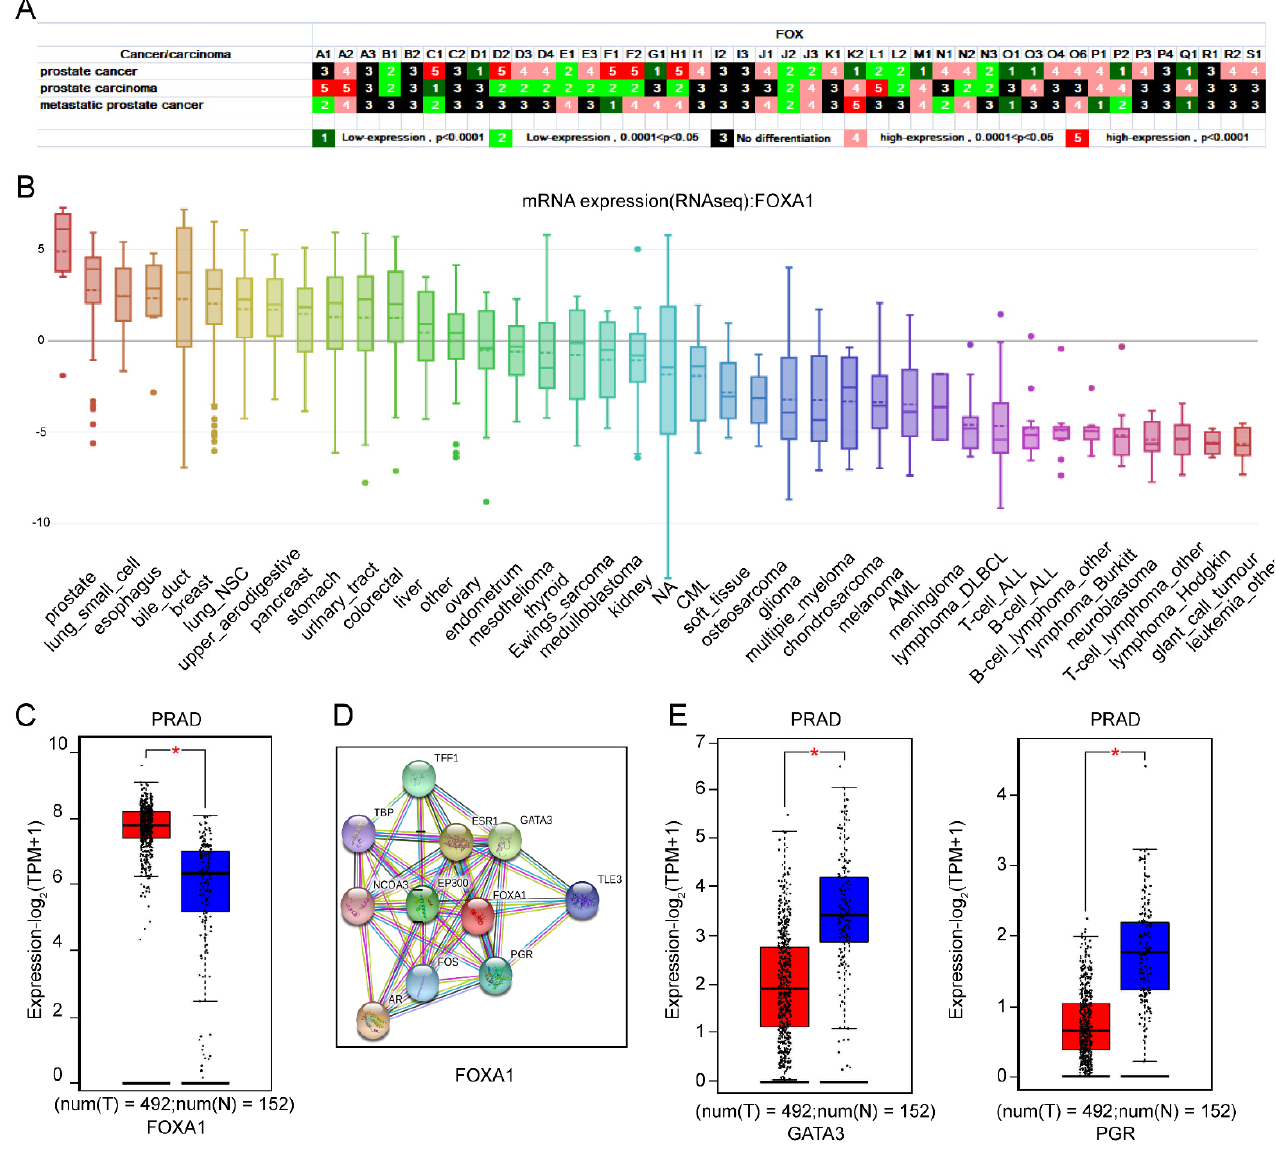
Figure 4. Differential expression of FOX genes in prostate cancer ( A ). ( B ) The expression of FOXA1 in different cell lines. ( C )The Differential expression analysis of FOXA1 was carried out between PRAD and normal tissues. ( D ) The respective PPI network of FOXA1 . ( E ) Difference of GATA3 and PGR expression between PRAD and normal tissues. p values less than 0.05 were considered to be statistically significant, * p < 0.05.